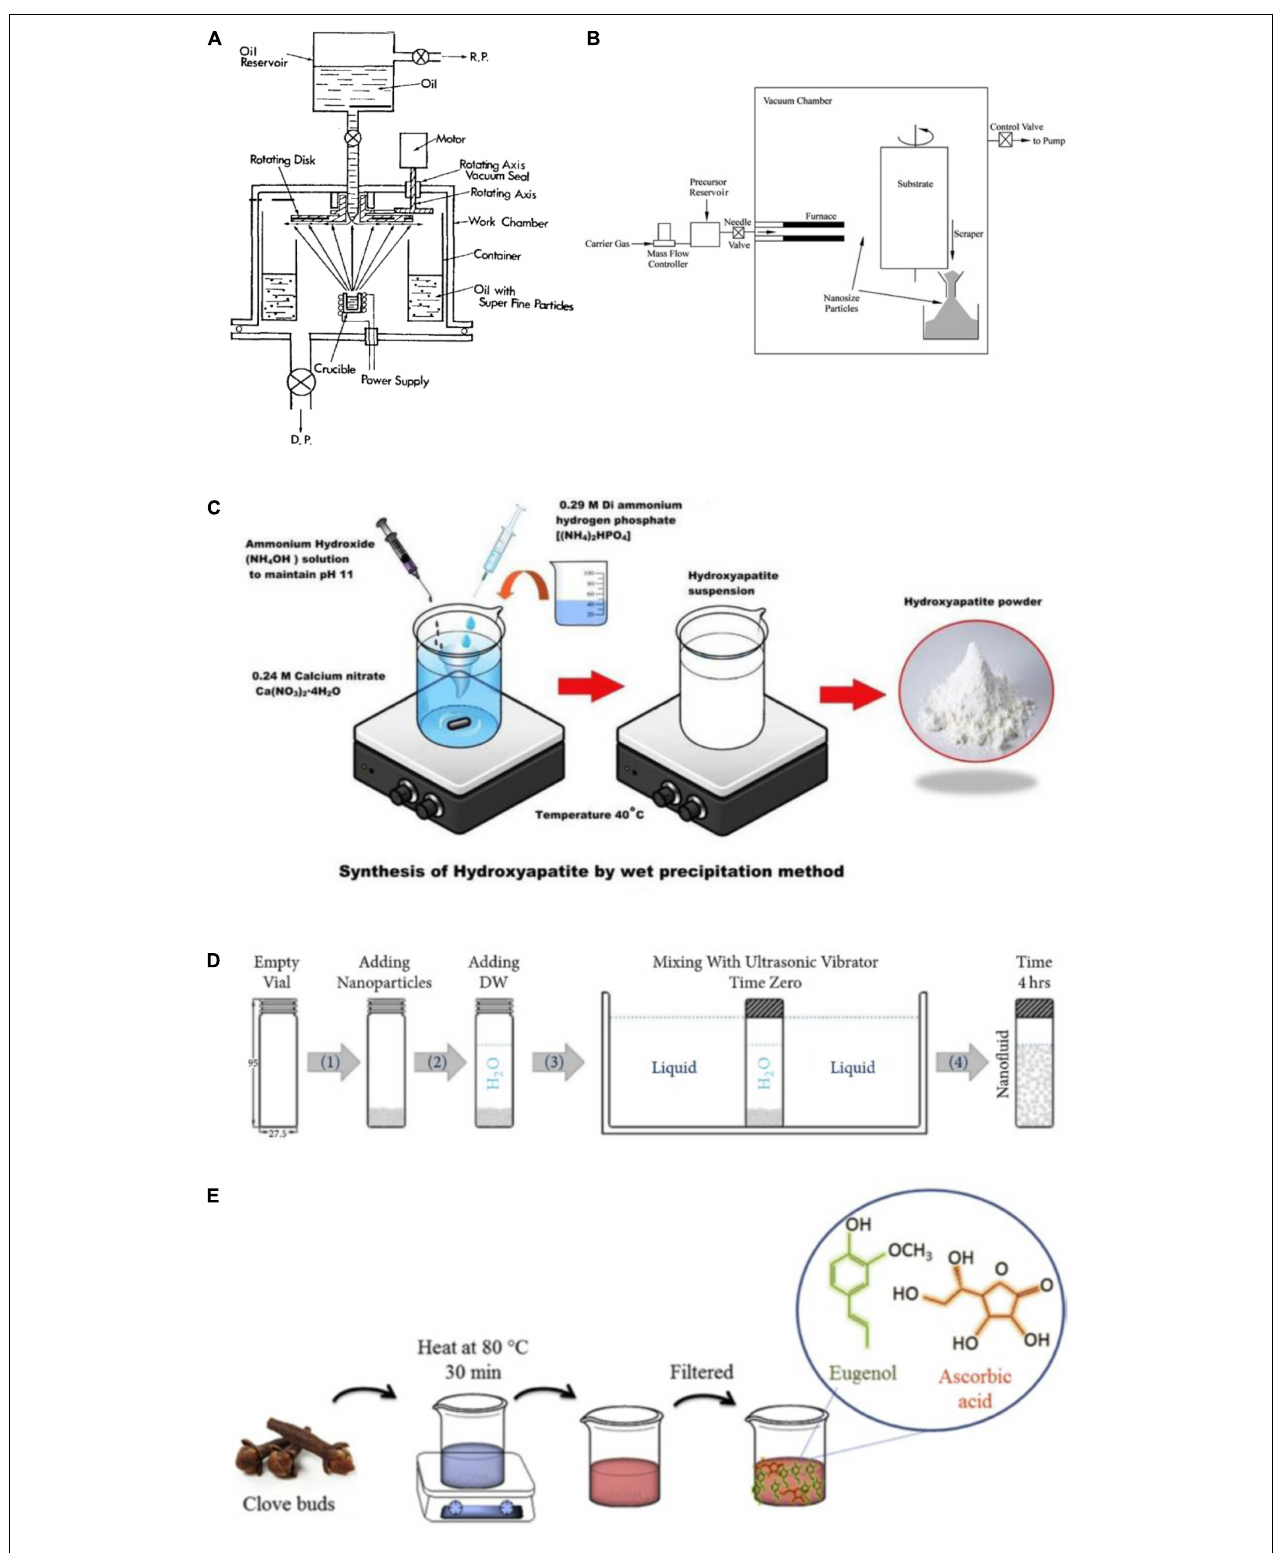
FIGURE 2 | Different preparation methods of organic nanofluid. (A) Vacuum evaporation into a running oil substrate process by Akoh et al. (1978), (B) chemical vapor condensation process by Wang et al. (2003), (C) chemical precipitation process by Mondal et al. (2016), (D) condensation/dispersion method by Ali et al. (2018), and (E) bio-based process by Sadri et al. (2017).